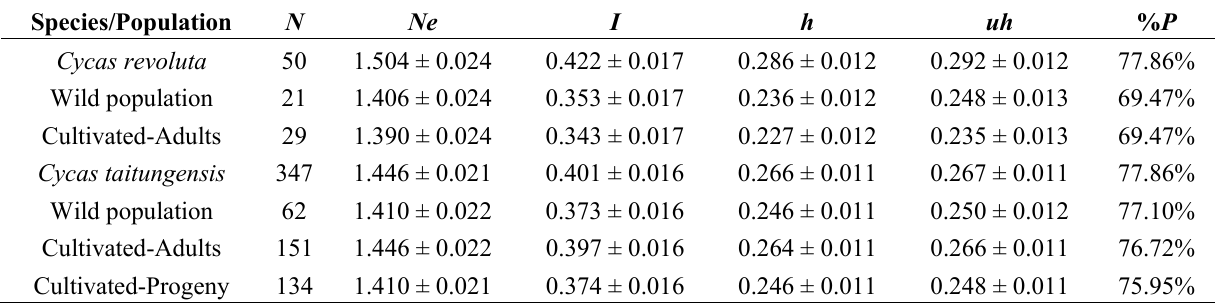
Table 1. Genetic diversity of wild populations and cultivated samples of C. revoluta and C. taitungensis estimated using 262 neutral AFLP